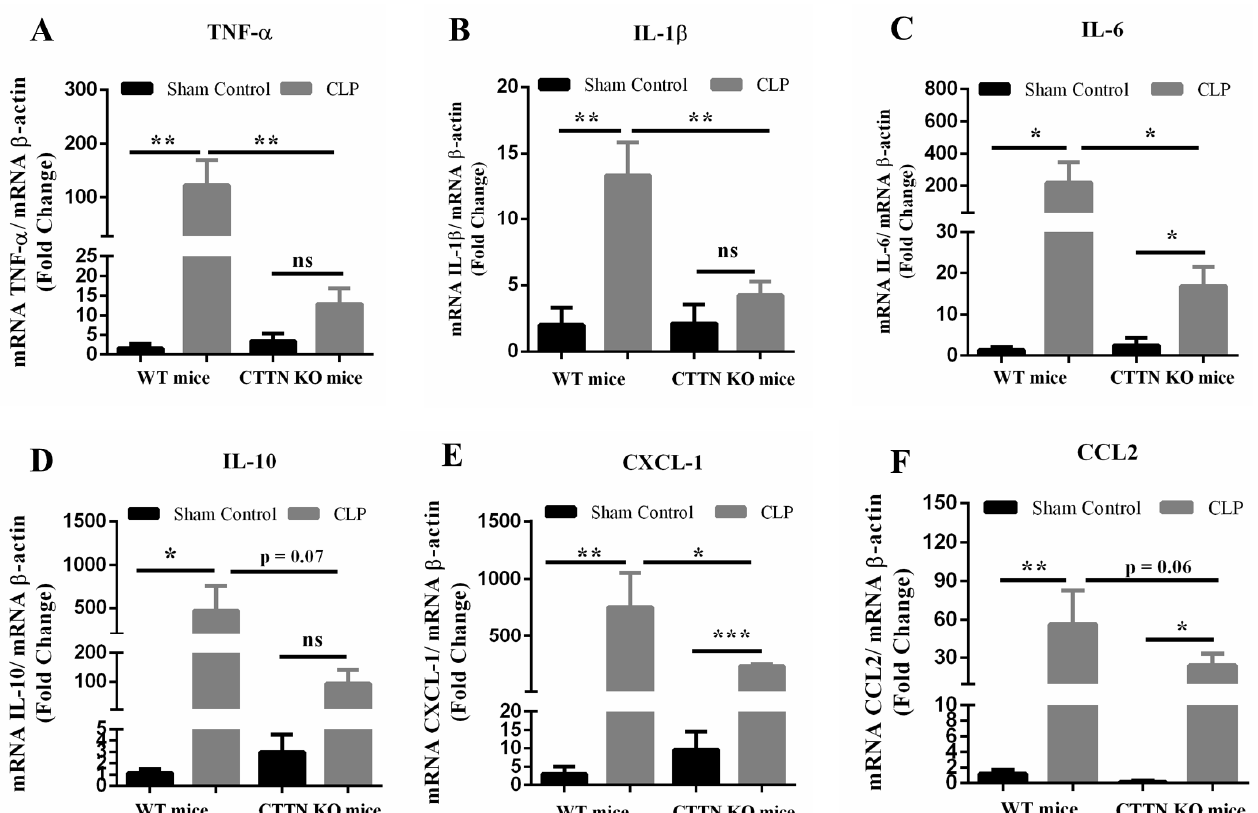
Figure 2. Cortactin deficiency attenuates the inflammatory response in the lung during sepsis. Relative gene expression of the pro-inflammatory cytokines ( A ) TNF- α , ( B ) IL-1 β , ( C ) IL-6, ( D ) IL-10, and chemokines ( E ) CXCL-1, and ( F ) CCL2 was determined in the lung tissue 24 h after CLP or Sham surgeries. The ∆∆ Ct method was used to determine differences in gene expression shown as fold change normalised to the housekeeping gene β -actin. Data are represented as mean ± SEM of at least 5 animals per group. * p < 0.05, ** p < 0.01, *** p < 0.001, ns: non-significant.